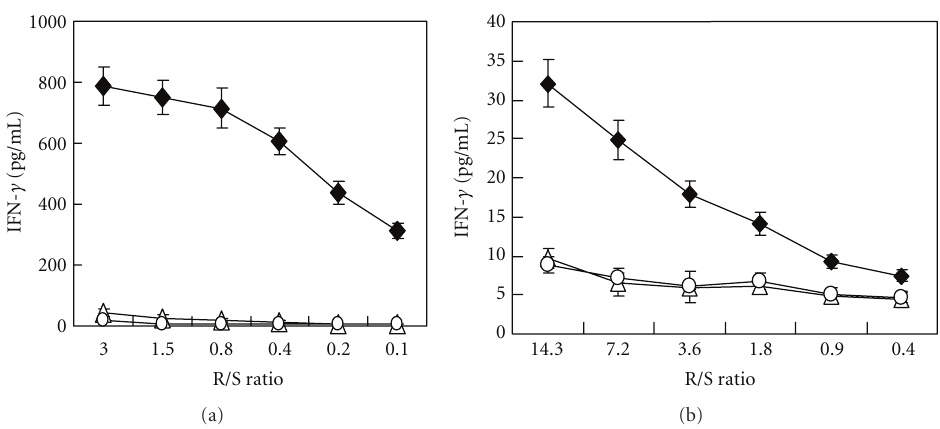
Figure 3: IFN- γ production by CTL clones responding to COS7 cells that expressing HLA-A ∗ 2402 and respective oncogene. (a) IFN- γ production by CDH3-10-807 peptide-specific CTL clone when exposed with COS7 cells expressing both HLA-A ∗ 2402 and CDH3 (closed diamond), HLA-A ∗ 2402 (open triangle), or CDH3 (open circle). (b) IFN- γ production by KIF20A-10-66 peptide-specific CTL clone when exposed with COS7 cells expressing HLA-A ∗ 2402 and KIF20A (closed diamond), HLA-A ∗ 2402 (open triangle), or KIF20A (open circle). Both CTL clones significantly produced IFN- γ responding to COS7 cells expressing HLA-A ∗ 2402 and corresponding gene. Similar results were obtained in three independent experiments. Independently induced other CTL clones also produced significant amount of IFN- γ when exposed with COS7 cell expressing both HLA-A ∗ 2402 and respective gene (data not shown). R/S ratio, responder cell (CTL clone)/stimulator cell (COS7 cell)